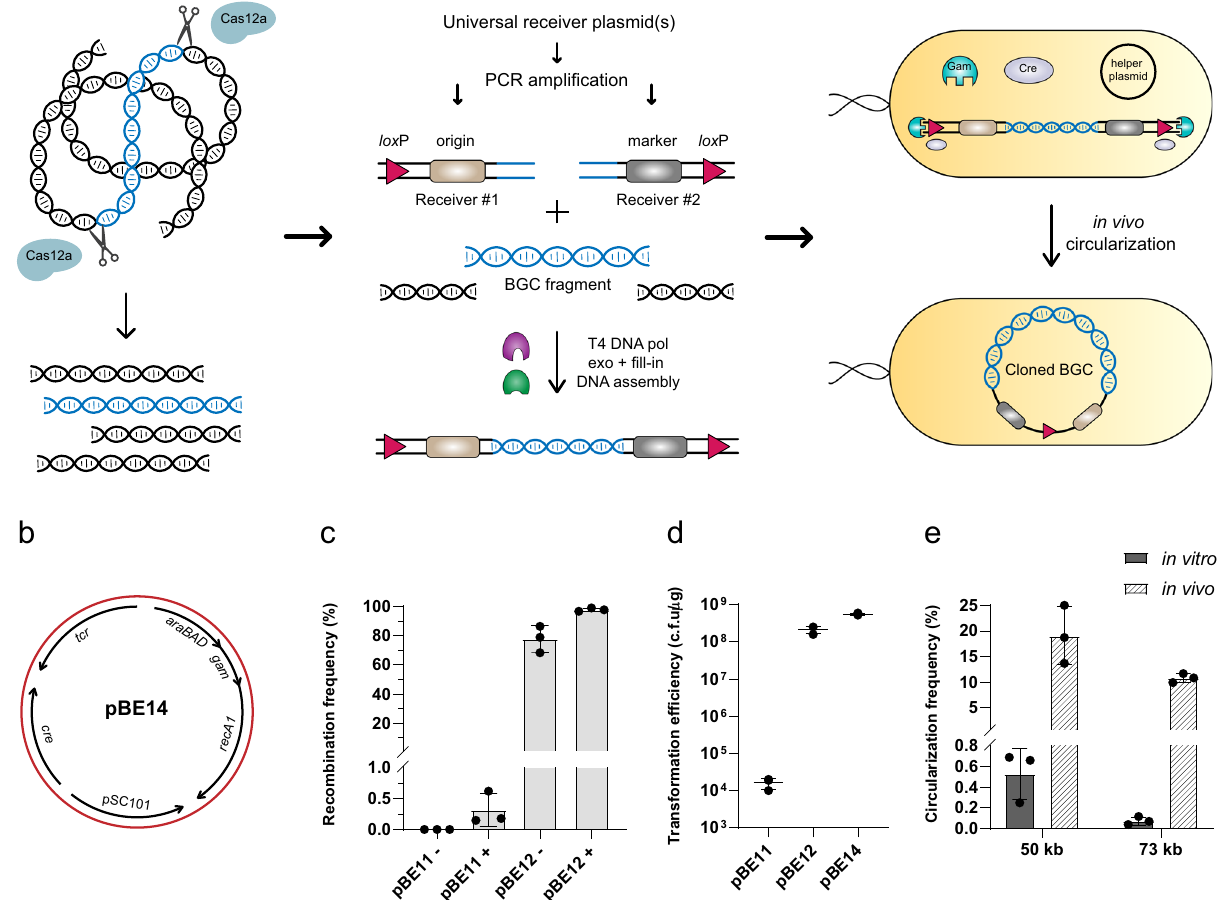
Fig. 1 Development of the CAPTURE method. a Overview of the work fl ow. In the fi rst step, puri fi ed genomic DNA is digested by Cas12a enzyme to release the target BGC fragment. In the second step, digestion products are mixed with two DNA receivers containing lox P sites at their ends. The target BGC fragment and DNA receivers are assembled together using T4 DNA polymerase exo + fi ll-in DNA assembly. In the fi nal step, the assembly mixture is transformed into E. coli cells harboring a circularization helper plasmid. The linear DNA is able to circularize in vivo by Cre- lox recombination. b DNA map of helper plasmid pBE14. tcr : tetracycline resistance marker; araBAD : L-arabinose inducible promoter and its regulator; gam : phage lambda Red gam gene; pSC101: temperature-sensitive origin of replication; recA1 : mutated E. coli recA gene to increase transformation ef fi ciency. c Comparison of recombination frequency between Flp (pBE11) and Cre (pBE12) helper plasmids. -: without L-arabinose induction, + : with L-arabinose induction. Recombination frequencies were calculated based on the ratio of white colonies to the total number of acquired colonies. d Linear DNA transformation ef fi ciency for E. coli similar to circular DNA. e Comparison of in vitro versus in vivo circularization for two large (50 kb, 73 kb) linear DNA molecules. In vivo circularization showed ~33-fold and 150-fold higher frequency than in vitro circularization for 50 kb and 73 kb molecules, respectively. Circularization frequencies were calculated based on the number of colonies acquired for each circularization experiment in comparison to the number of colonies acquired after transformation of the original circular DNA (see Methods for full description). Each experiment was performed in three biological replicates and data are presented as mean values ± standard deviation (SD). Source data are provided as a Source Data fi